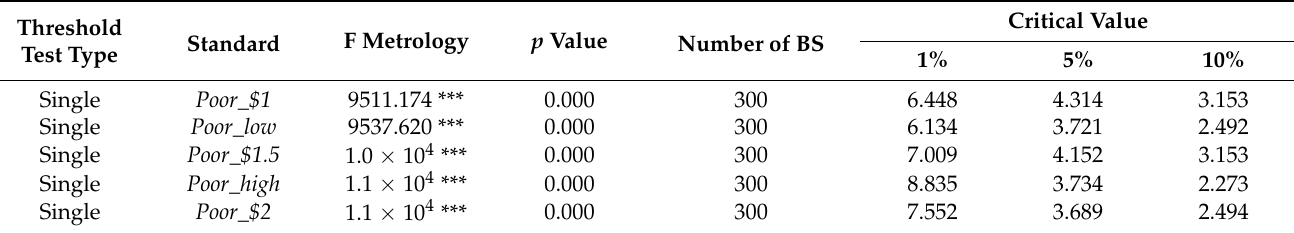
Table 17. Threshold effect of self-sampling test.